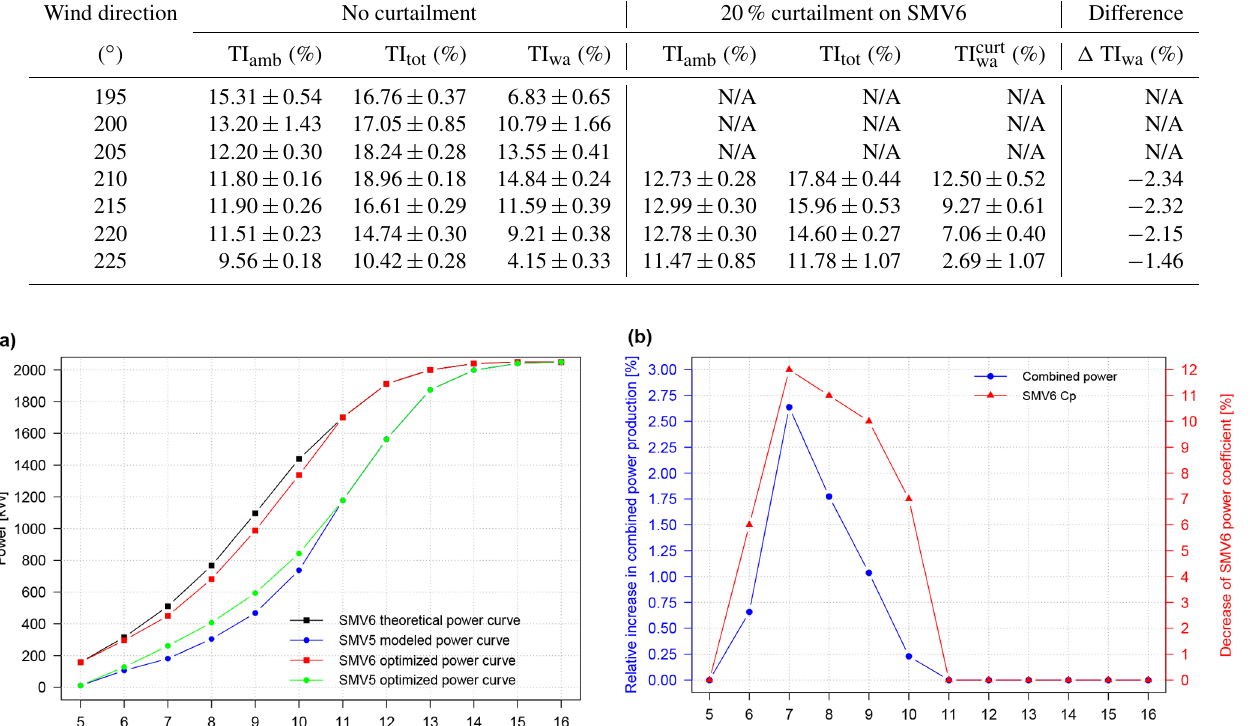
Table 1. Comparison of measured wake-added TI at SMV5 wind turbine between no curtailment and 20% curtailment on SMV6, with their 68% normalized confidence interval. N/A (not applicable) indicates missing data for some wind direction bins.